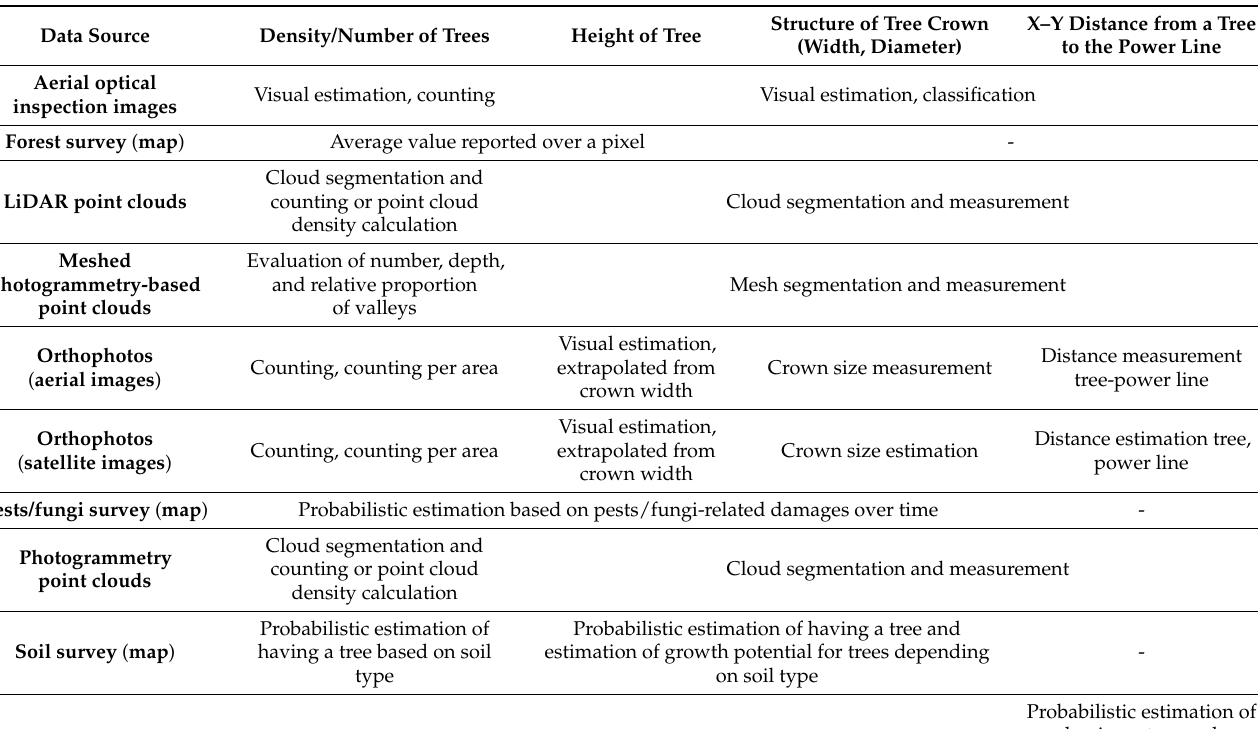
Table A5. Suggestions of preprocessing methods usable to link the data sources to the selected